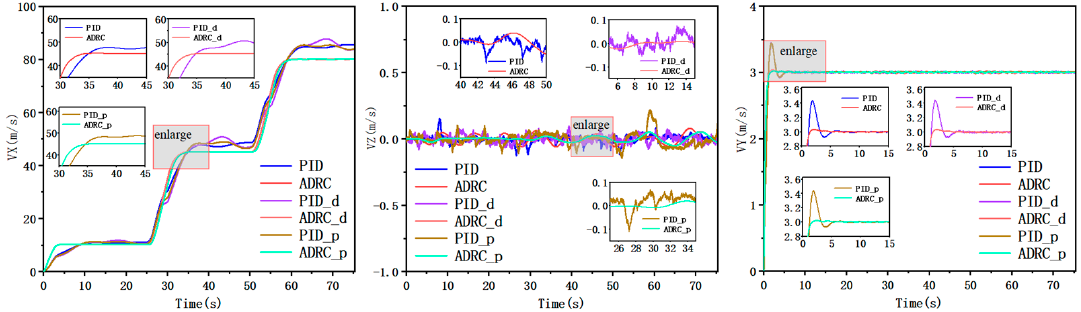
Figure 15. Three-axis velocity response in body axis.